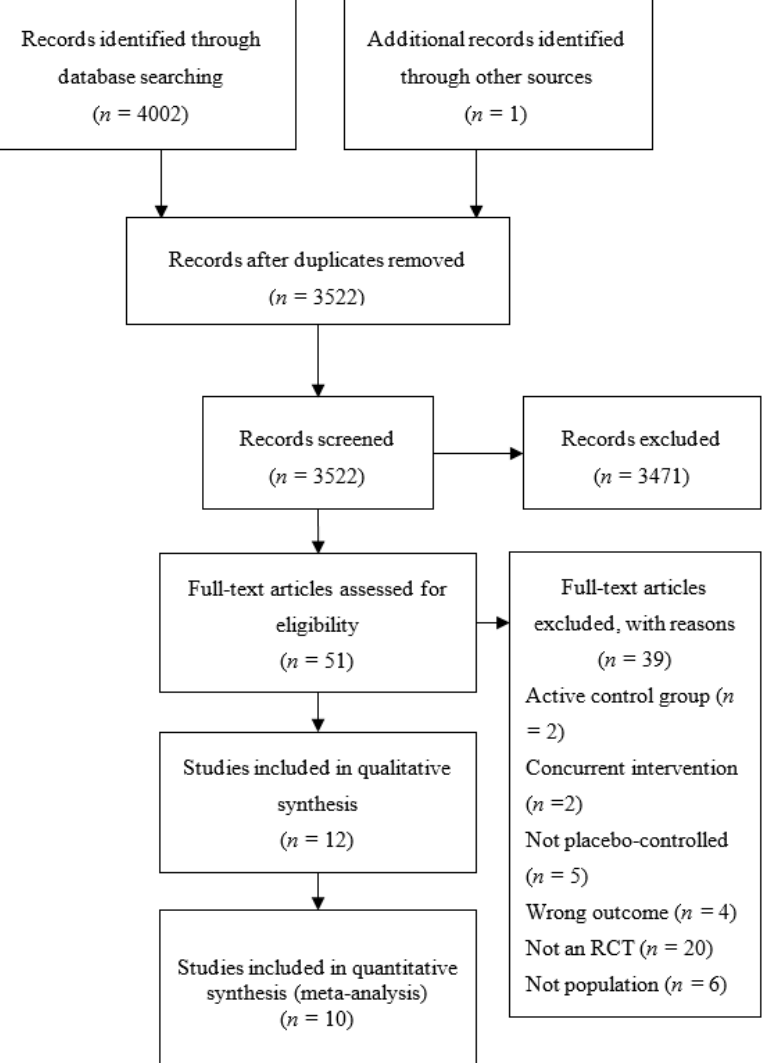
Figure 1. Preferred Reporting Items for Systematic Reviews and Meta-Analyses (PRISMA) study flow diagram describing process of study selection.